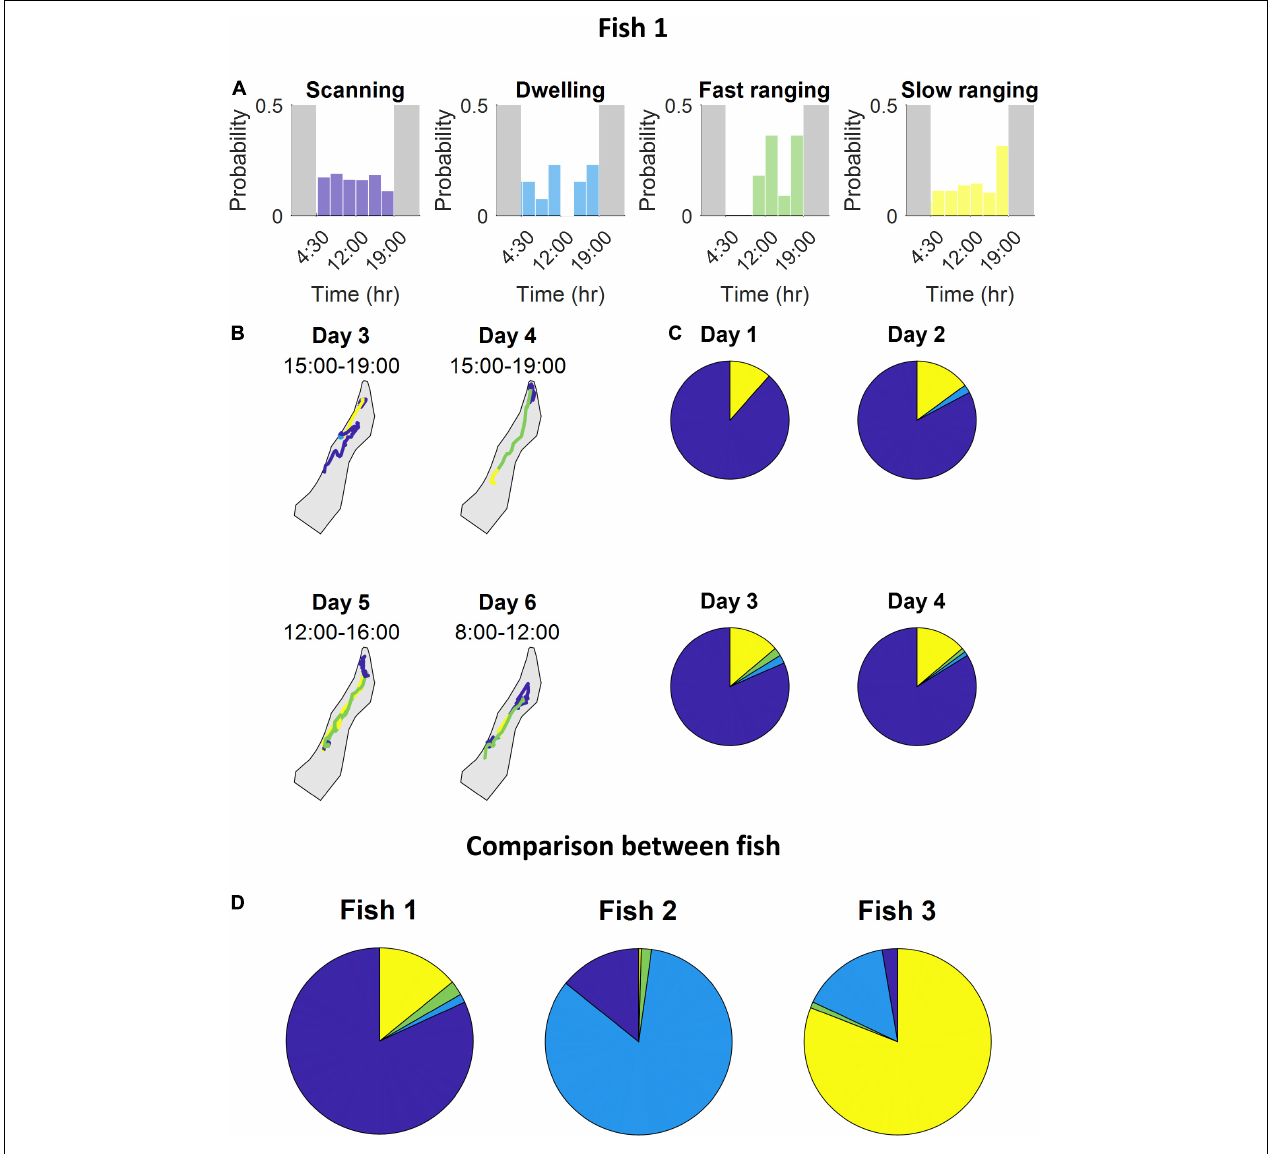
FIGURE 6 | The fish use multiple strategies during the day while exploring the coral reef environment. (A) For each class, the probability segments appearing at specific times throughout the day. (B) Several examples of 4-h long trajectory segment sequences the fish used to travel between areas where it scans and dwells. (C) The time one fish spent engaging in each class of trajectory segments over four consecutive days. The days were similar in their class distribution. (D) Time-division of engagement in each class throughout the entire tracking period of each fish. Stability tested among different day groups resulted in a standard error percentage of fish 1 – [0.2,23,36,2.4], fish 2 – [22,4.2,71,0], fish 3 – (28,0.6,24,0.4) for scanning, dwelling, fast ranging and slow ranging, respectively. Variation tested among all fish yielded that all but one class have a substantial variability with a minimal standard error of 75%, fast ranging being the exception with a standard error of 24% (all color maps relate to Figure 5B